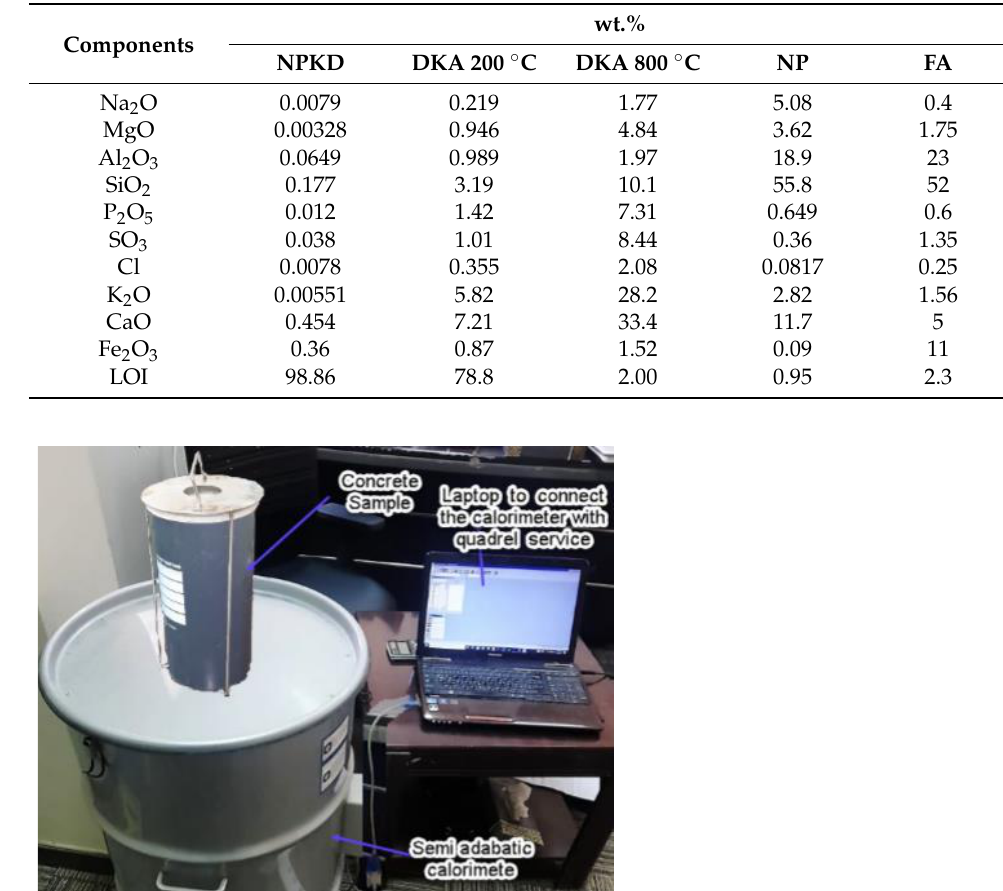
Table 4. XRF analysis of DKA, NP, and FA.